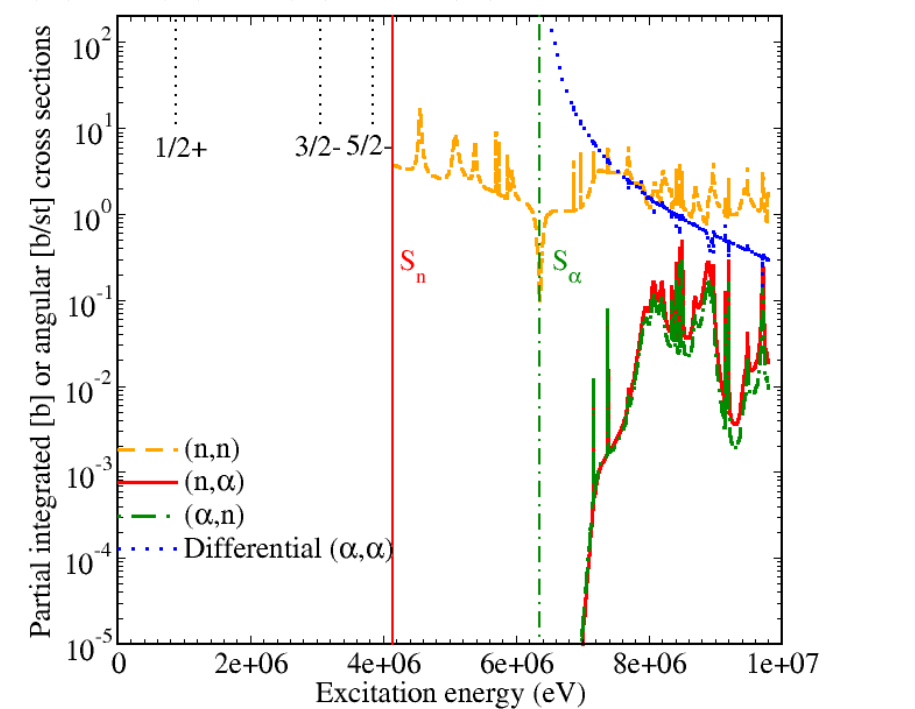
Fig.2 . The 16 O(n,n) 16 O (long dash curve), 16 O(n, α ) 13 C (solid curve) , 13 C( α ,n) 16 O (long-short dash curve) and 13 C( α , α ) 13 C (dotted curve) cross sections. The targets are respectively 16 O and 13 C in their ground states. Vertical solid and dash lines indicate respectively the position of the separation energies of the neutron and α particle on the energy scale. The dotted vertical lines indicate the position of the three bound states of the 17 O* nucleus below the separation energy of the neutron. Present differential cross section (α,α) is computed according Blatt and Biedenharn formalism [12] at the CoM angle of 54 degrees (the CoM angle of 54 degrees was chosen in concern of reproducing existing observable based on existing experimental data of Barnes [13] at 54.7